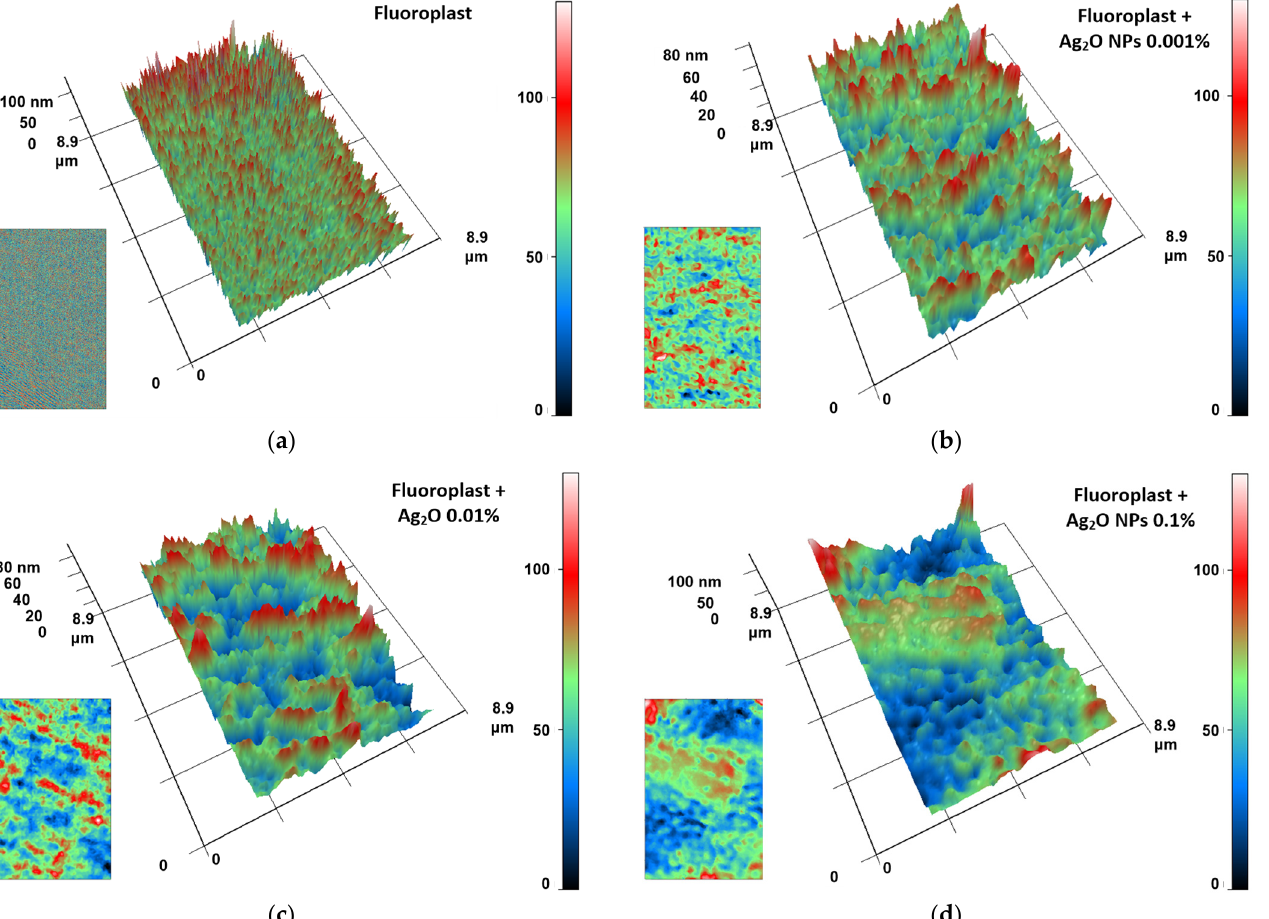
Figure 4. The results of the analysis of the fluoroplast/Ag 2 O NPs composite coating by MIM method: ( a ) PTFE without the addition of nanoparticles; ( b ) PTFE with the addition of 0.001% Fe 2 O 3 nanoparticles; ( c ) PTFE with the addition of 0.01% Fe 2 O 3 nanoparticles; ( d ) PTFE with the addition of 0.1% Fe 2 O 3 nanoparticles. The images are presented as 3D reconstructions, where the abscissa and ordinate axes correspond to the real distance in µm. The Oz axis displays the phase difference in nm (the larger the phase difference, the higher the value on the Oz axis). Coloring is a pseudo color. The initial data on the spatial distribution of the phase difference in the analyzed sample, used to construct 3D reconstructions, are shown in the lower left corners of each panel.